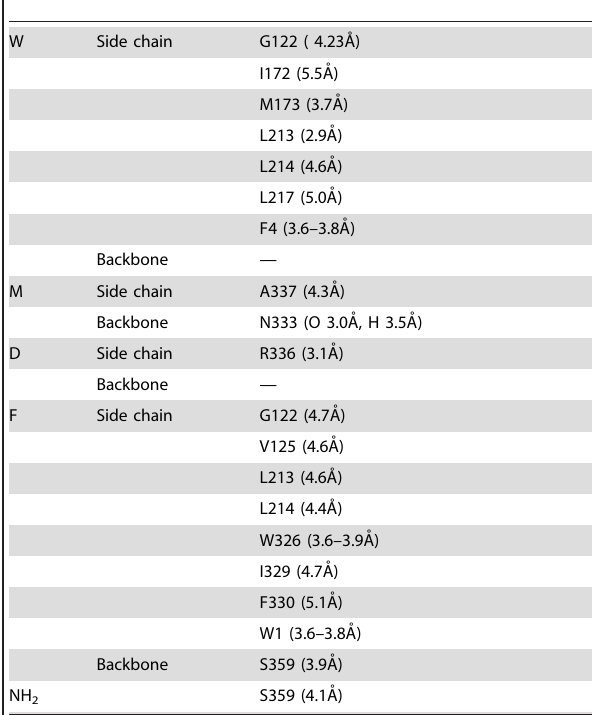
Table 1. WMDF-NH 2 ligand-receptor contact sites a .